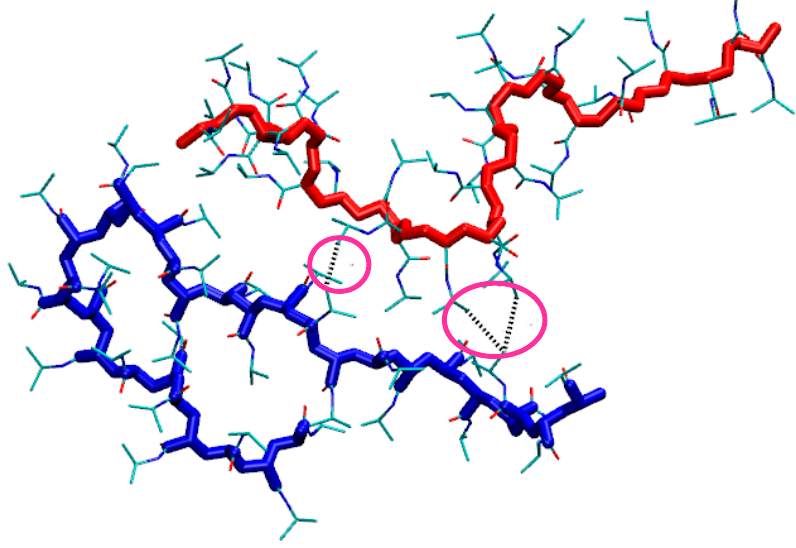
Figure 7. Snapshot at about 130 ns of the trajectory of the isotactic-rich PNIPAM at 283 K. Water and hydrogen atoms are omitted. The backbone atoms are coloured in red and blue for chain A and B, respectively. The pink circles highlight the junctions.